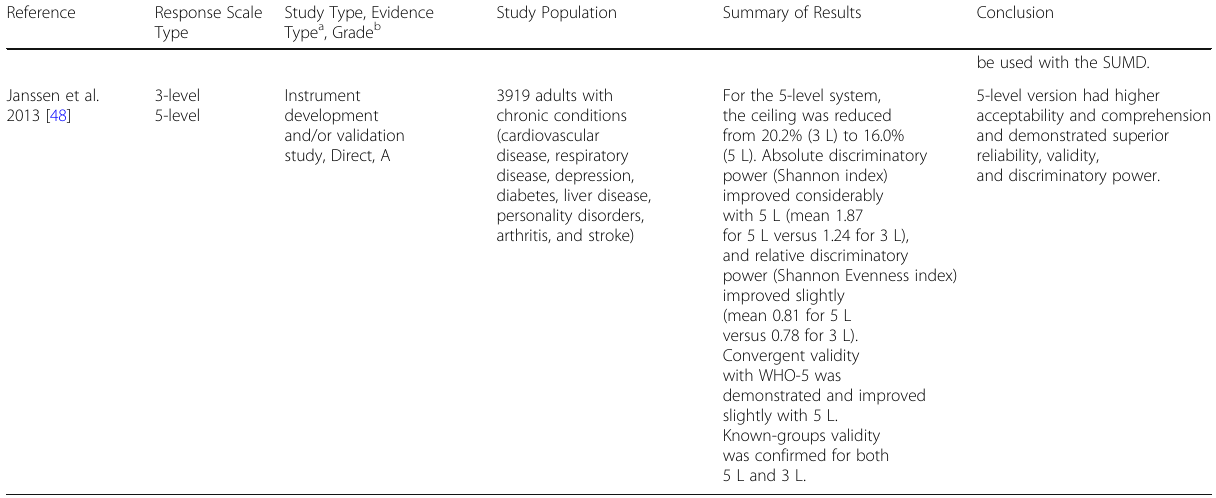
Table 4 Key studies that support response scale selection used in PRO instruments based on optimal response set number